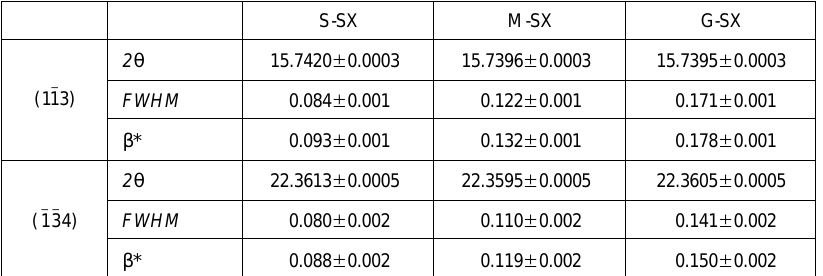
Table I The position ( 2 θ ), width ( FWHM ) and integral breadth ( β * ) of characteristic diffraction peaks of the salmeterol xinafoate